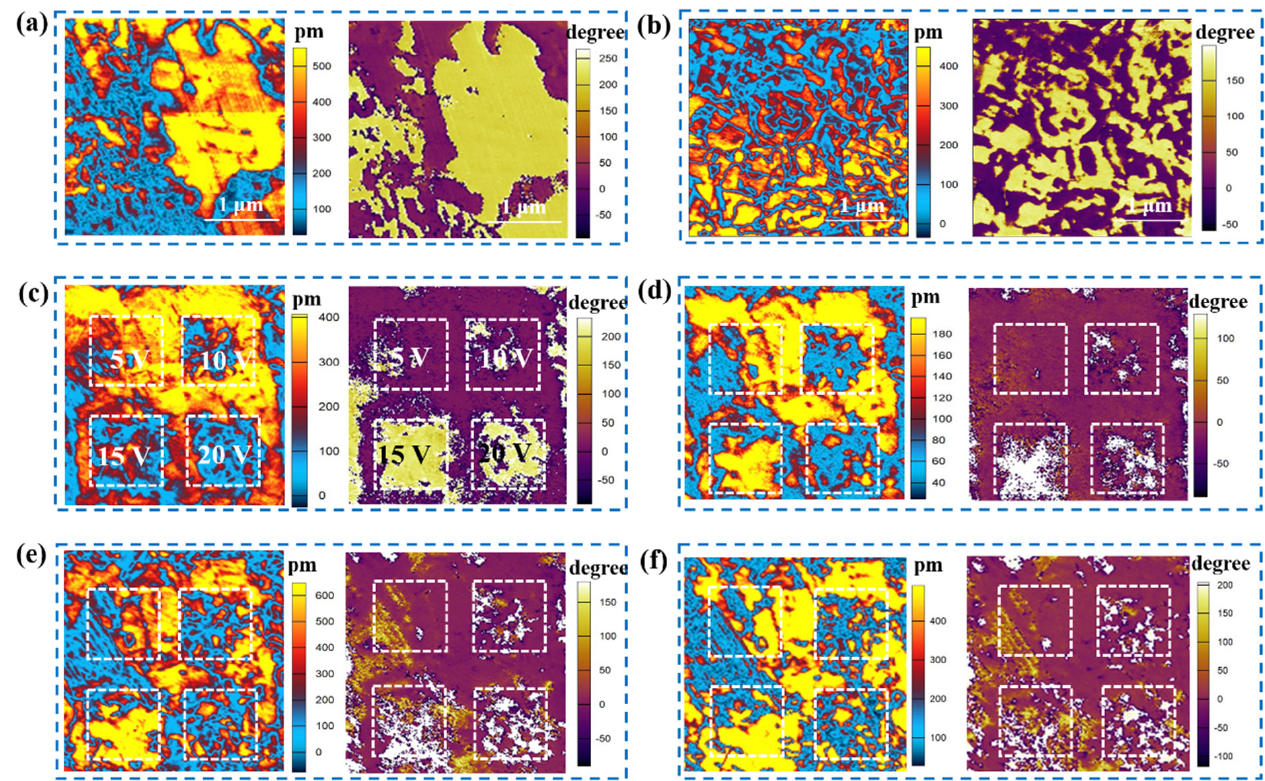
Figure 4. ( a ) The piezo-response force microscopy (PFM) amplitude and phase images of KNN-UN with a scan area of 3 × 3 μ m; ( b ) the piezo-response force microscopy (PFM) amplitude and phase images of KNN-800 with a scan area of 3 × 3 μ m; ( c – f ) the Litho mode of KNN-800 at 20 °C, 60 °C, 80 °C and 100 °C, including amplitude and phase images with a scan area of 3 × 3 μ m.